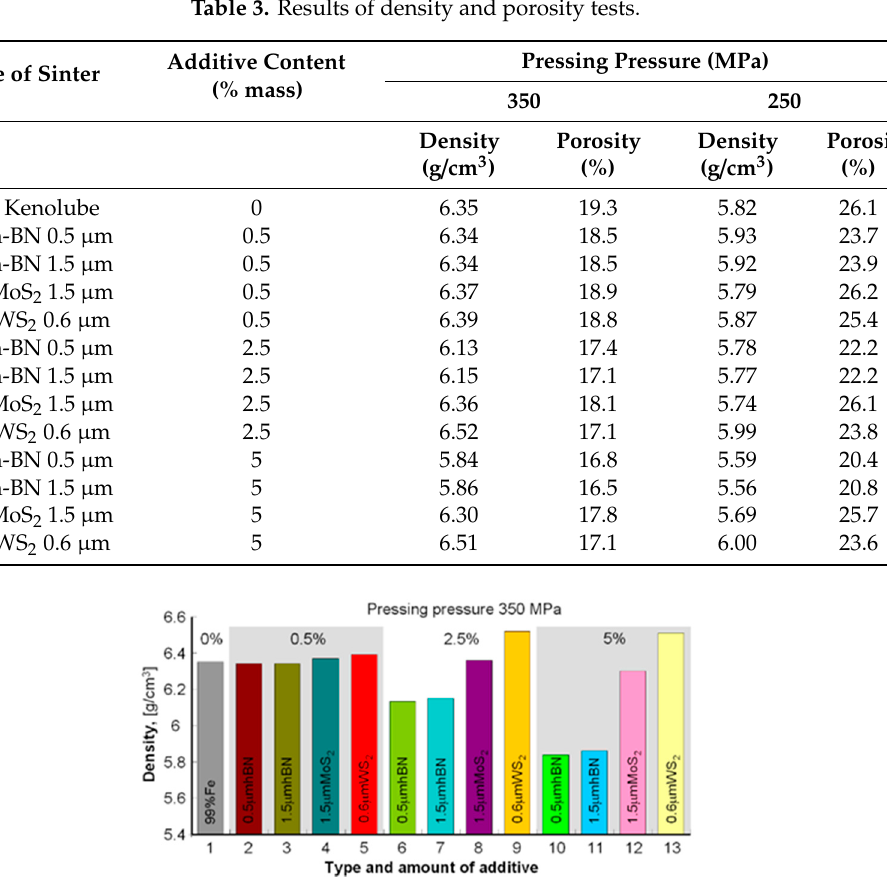
Figure 1. Sample densities after pressing 350 MPa and sintering.